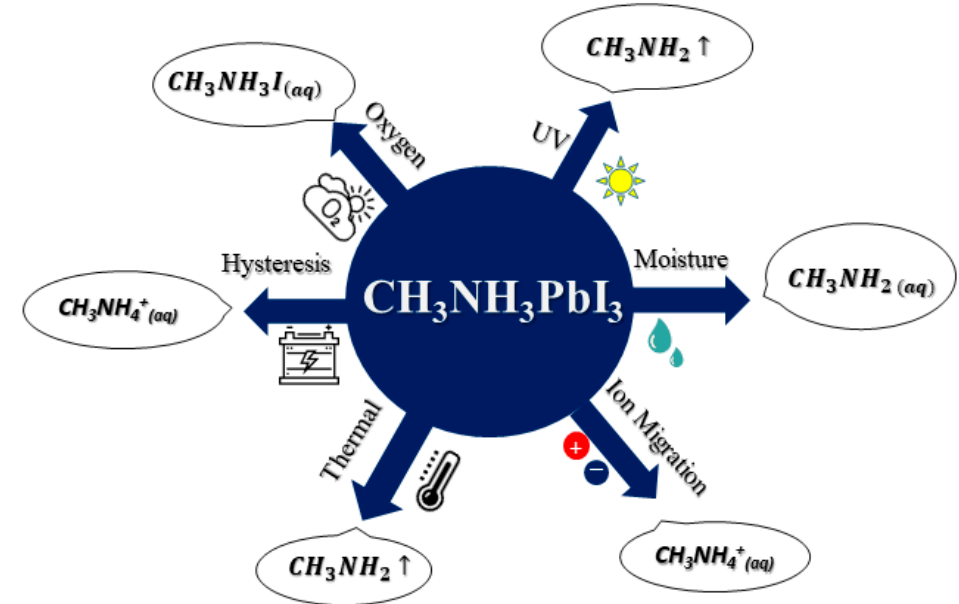
Figure 2. Major instability issues of perovskite solar cells.